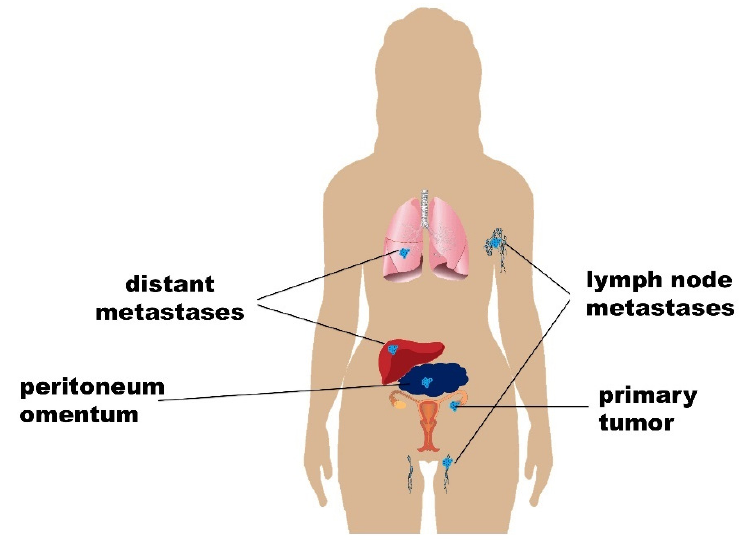
Figure 2. Metastatic routes of ovarian cancer (OC) metastasis. This scheme shows different metastatic scenarios in OC. The transcoelomic/peritoneal route is the main route in OC metastases development, especially into the peritoneum/omentum. During the subsequent progression, metastases in distant lymph nodes and organs (lungs or liver) are developed.